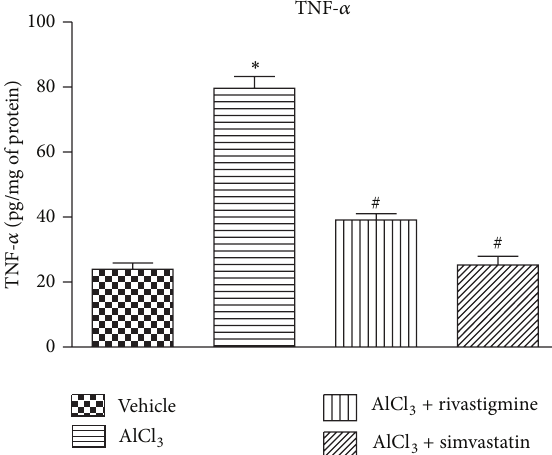
Figure 3: Effect of AlCl 3 and AlCl 3 + treatments on TNF- 𝛼 level in the hippocampus of rats. Data are presented as mean ± SEM ( 𝑛 = 8 ). ∗ 𝑃 < 0.05 as compared to control group and # 𝑃 < 0.05 as compared to AlCl 3 treated